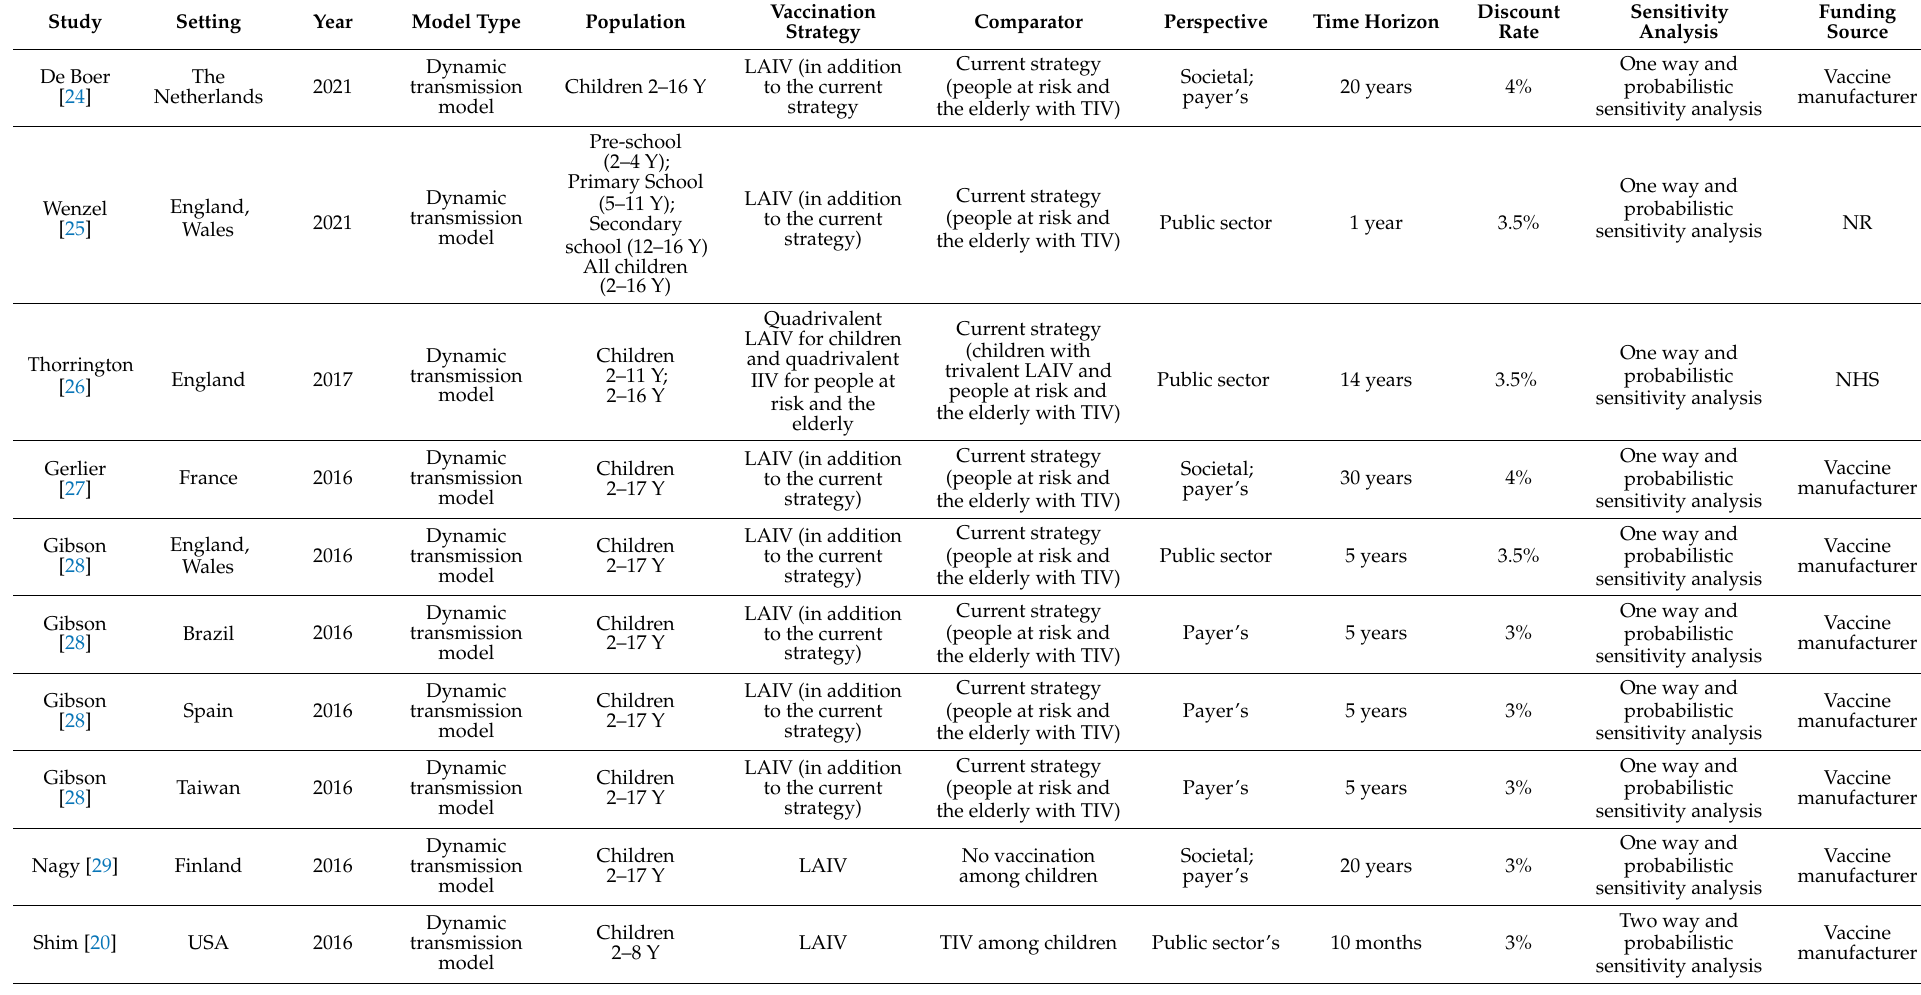
Table 1. The characteristics of the included